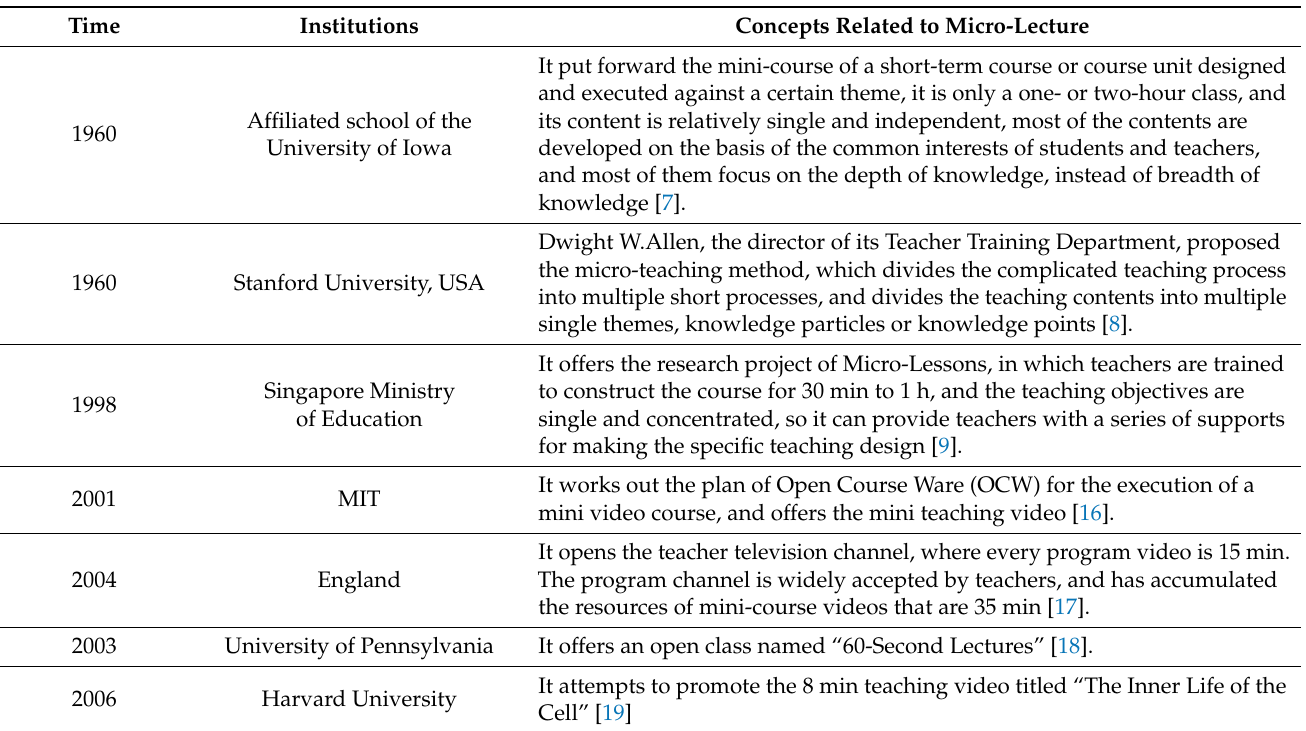
Table 1. Origin of the concept of micro-lecture.